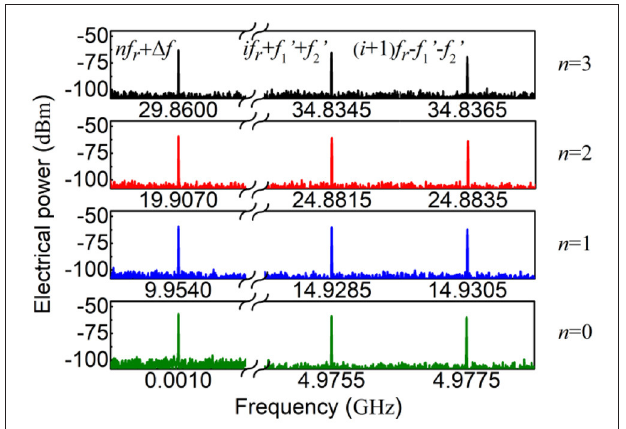
( = − 60.65 + 62.99) in the first segment ( n = 1). Similarly, the